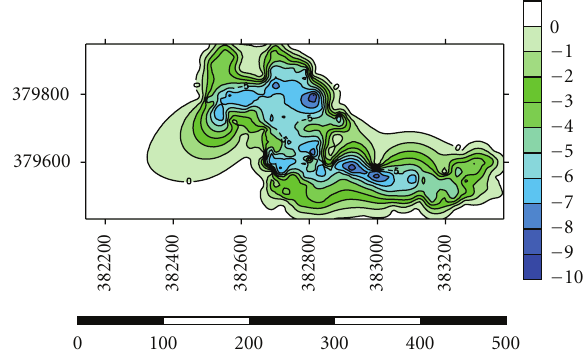
Figure 6: Showing depth at Lake B of the catchment.